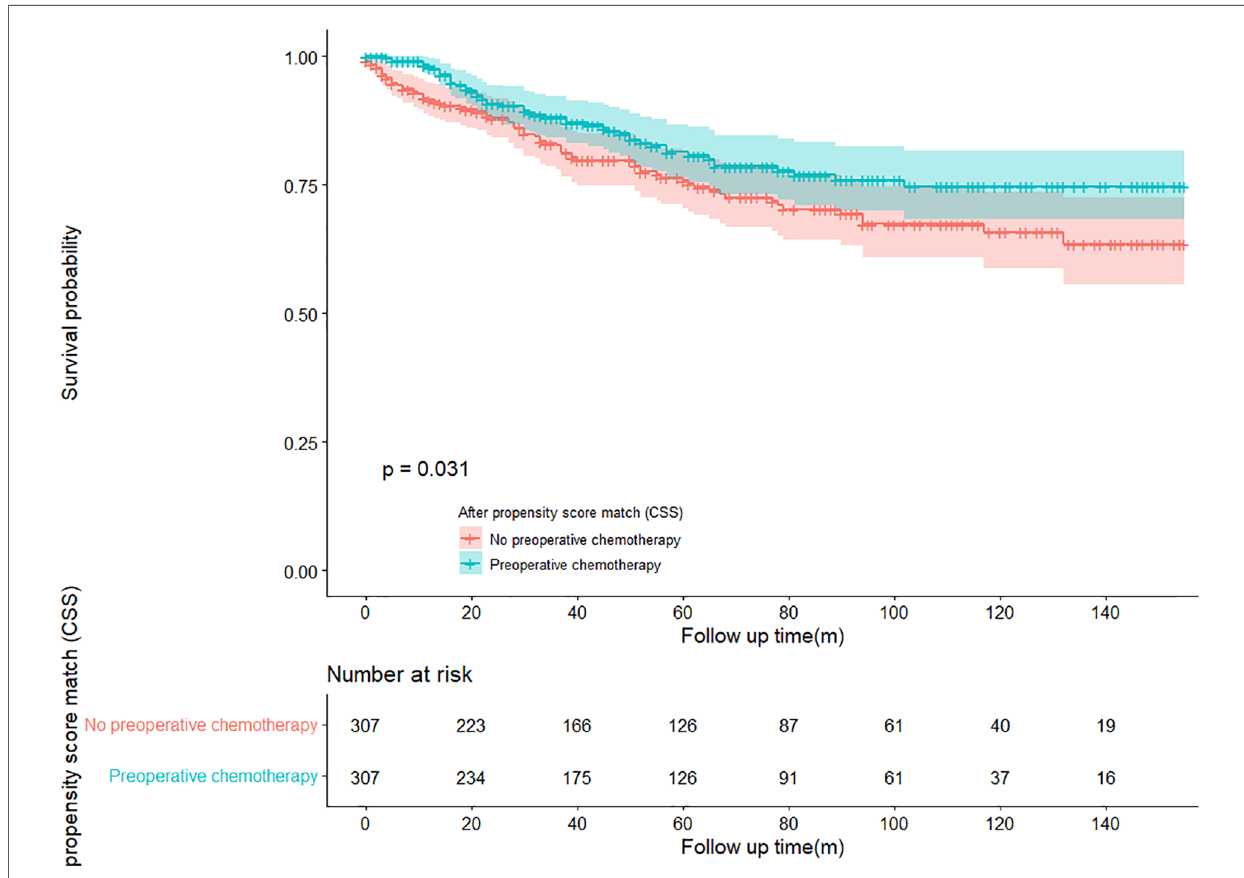
FIGURE 6 Survival curves of CSS in the POCT group and no-POCT group in patients undergoing surgery for TETs after propensity matching.